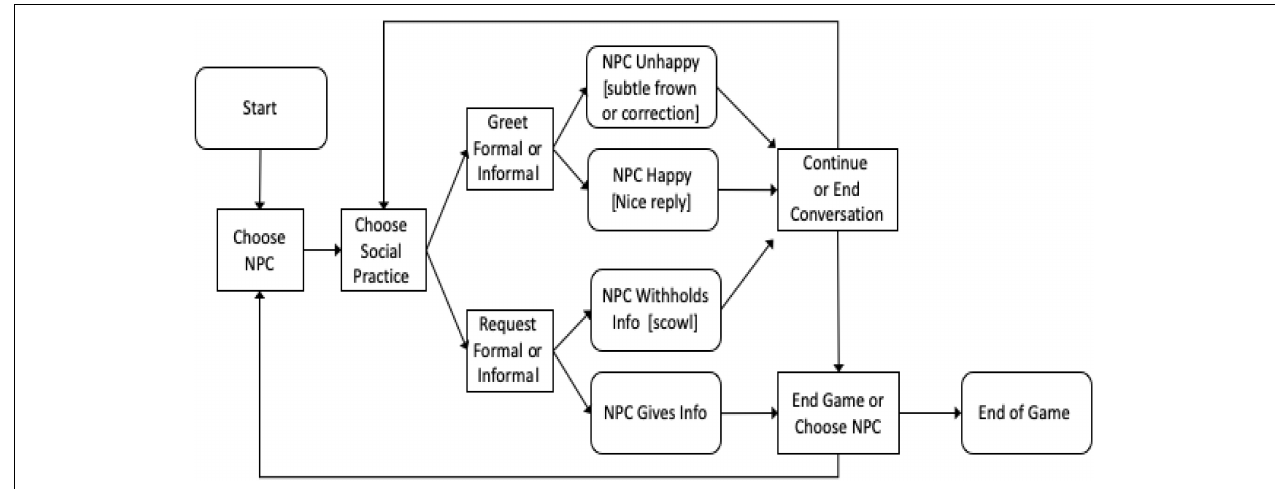
FIGURE 1 | Flow diagram for the simple version of the Ask-for-Water task. Square boxes represent choices that the player makes and round boxes indicate game states.